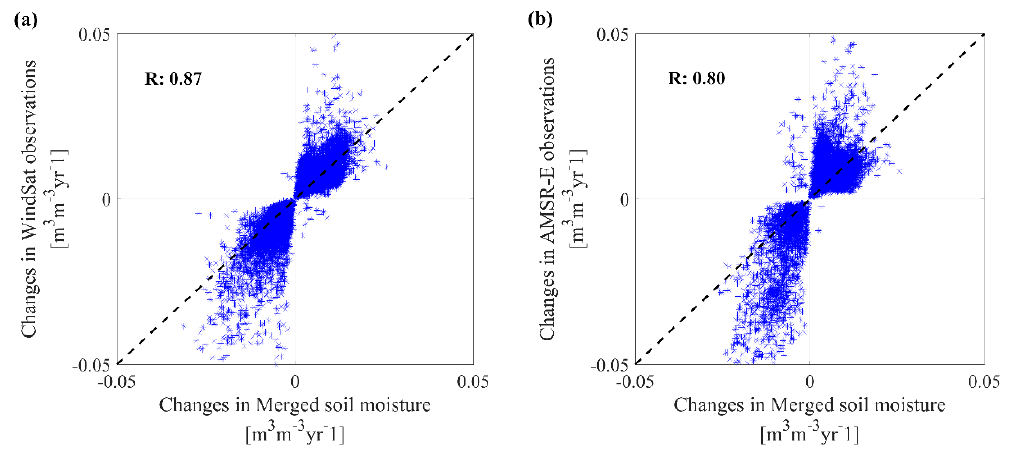
Figure 7. Relationship between long-term trends (change in soil moisture per year) of the merged product for time period 2 and the long term changes in soil moisture of ( a ) WindSat and ( b ) AMSR-E over time.